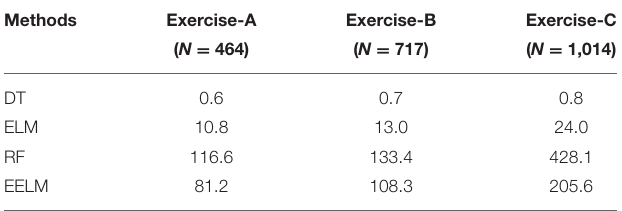
TABLE 2 | Run time of each method in recognizing gestures (ms).